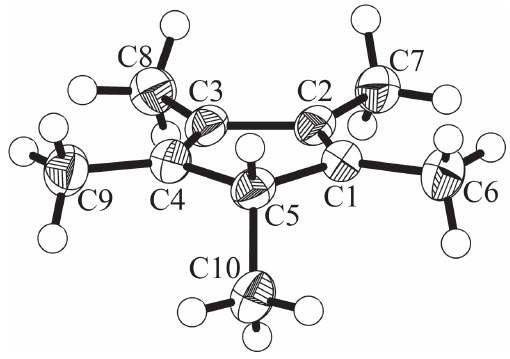
Table 1: Data collection and handling.